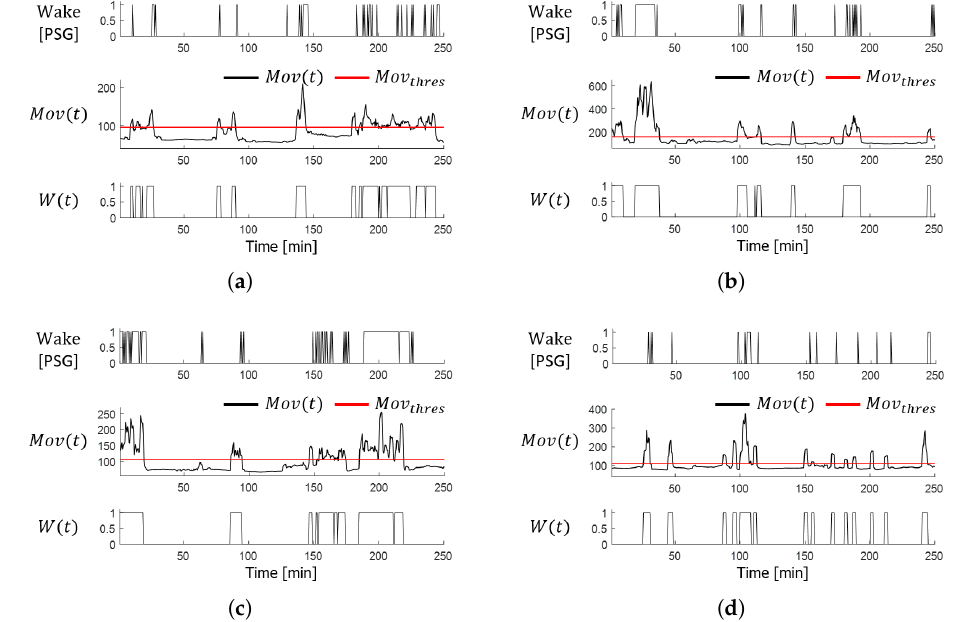
Figure 5. FMCW radar-based wake stage detection results. ( a ) Subject 1. ( b ) Subject 2. ( c ) Subject 3. ( d ) Subject 4.